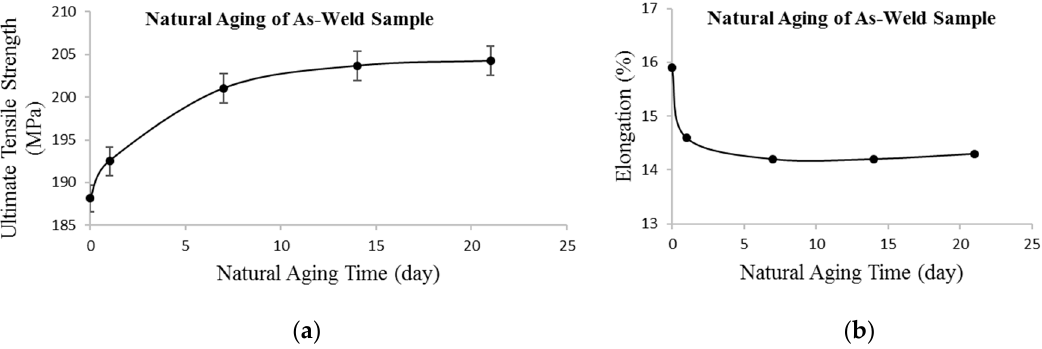
Figure 3. The effect of natural aging time on tensile strength: ( a ) And elongation; ( b ) of welded samples at optimized process parameters by right angle friction stir welding (RAFSW).